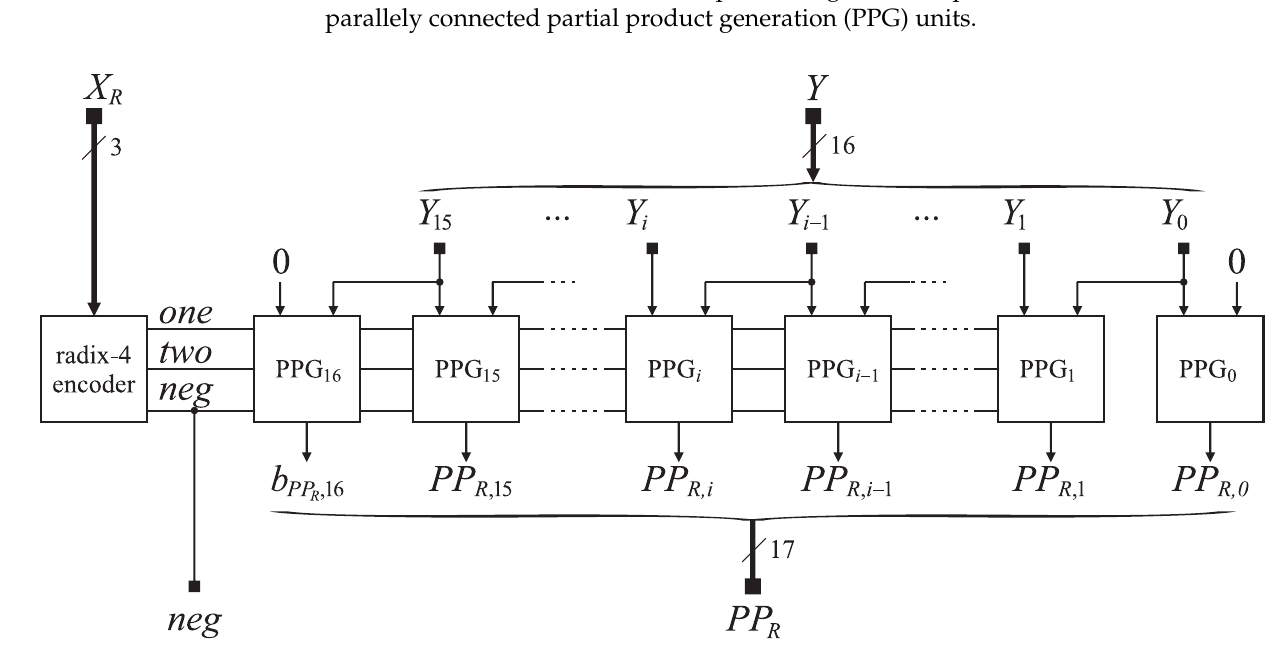
Figure 2. Exact radix-4 based